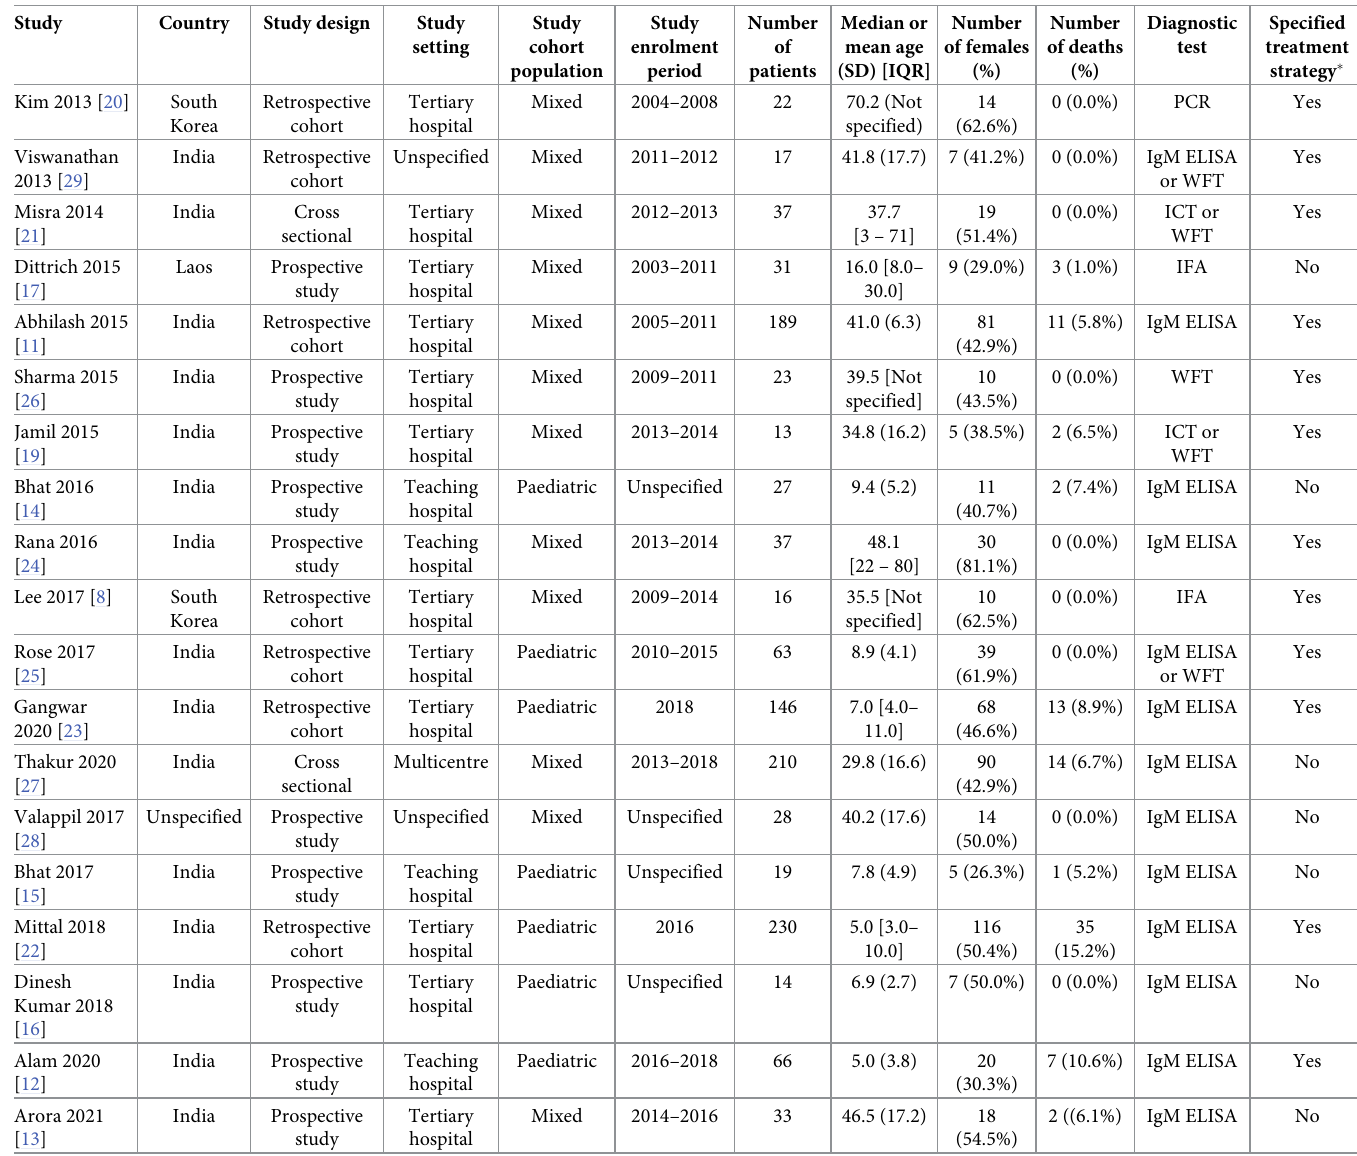
Table 1. General characteristics of included studies for meta-analyses; � = specification of treatment strategy required reporting of what antibiotics (if any) were given to enrolled patients; PCR = polymerase chain reaction; ELISA = enzyme-linked immunosorbent assay, IFA = immunofluorescence assay, ICT = immunochromatographic test, PCR = polymerase chain reaction, WFT = Weil–Felix